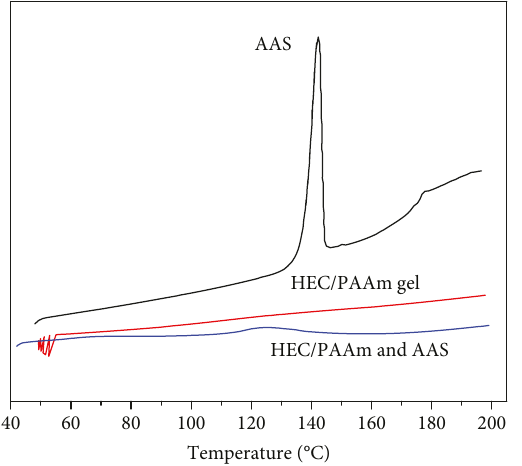
Figure 3: DSC-thermogram from the xerogel HEC/PAAm, ASA and HEC/PAAm and